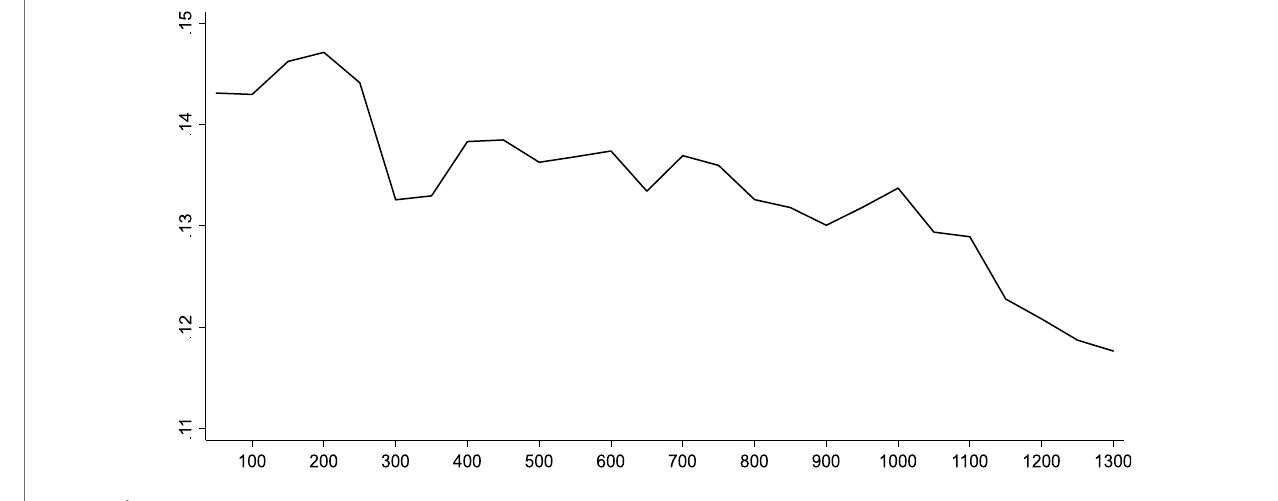
FIGURE 3 | Near feature of the resource curse spatial spillover effect.